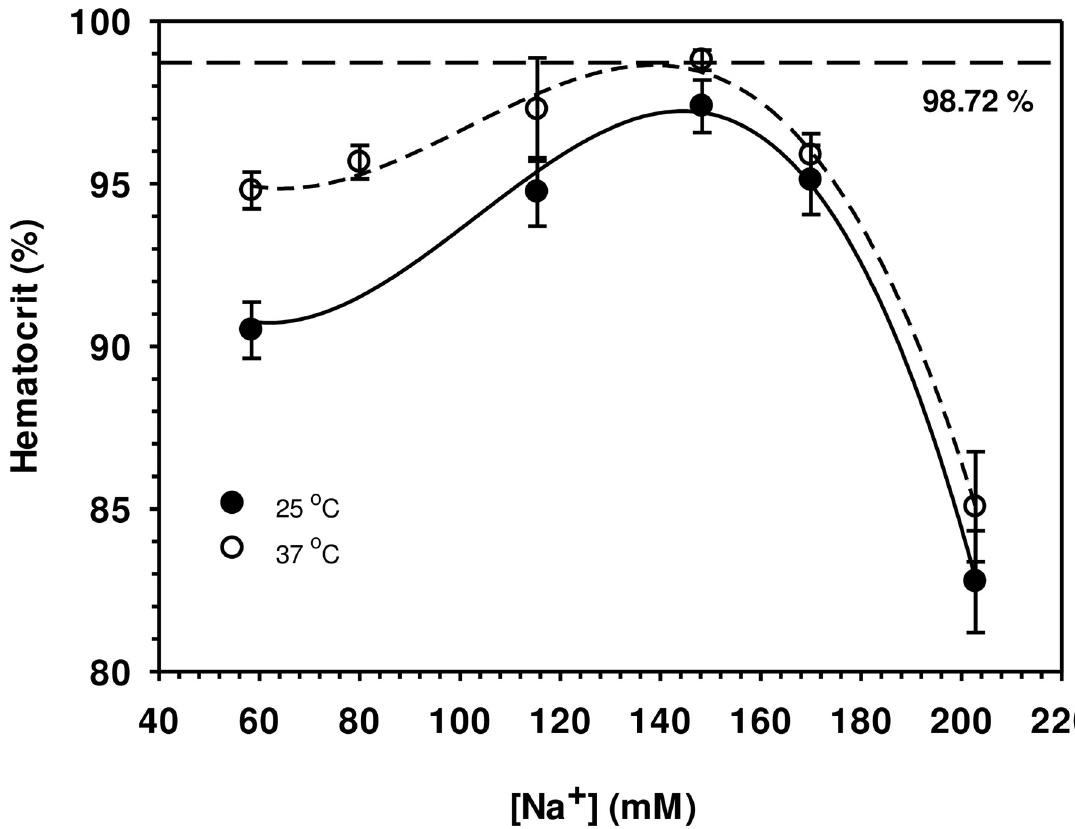
Fig 1. Haematocrit of red cells suspended in 5 different [NaCl] at 25 and 37˚C compared to that in the physiological state in which [NaCl] is 148 mM and temperature 37˚C (the reference lines on the graphs). The haematocrit volume plasma was 100% and 98.72% in 148 mM NaCl at 37˚C. Error bars are ± SE, means based on five replicates (5 separate individuals): the fitted lines are spline curves [35]. The Tukey test interval for testing for significant (p < 0.05) differences between any two mean values was V% = 5.513: V% at each [Na + ] at 25 vs . 37˚C were not significantly different under control and higher [Na + ] but diverged at 25˚C (lower) and 37˚C (higher) under the lowest (58 mM Na +